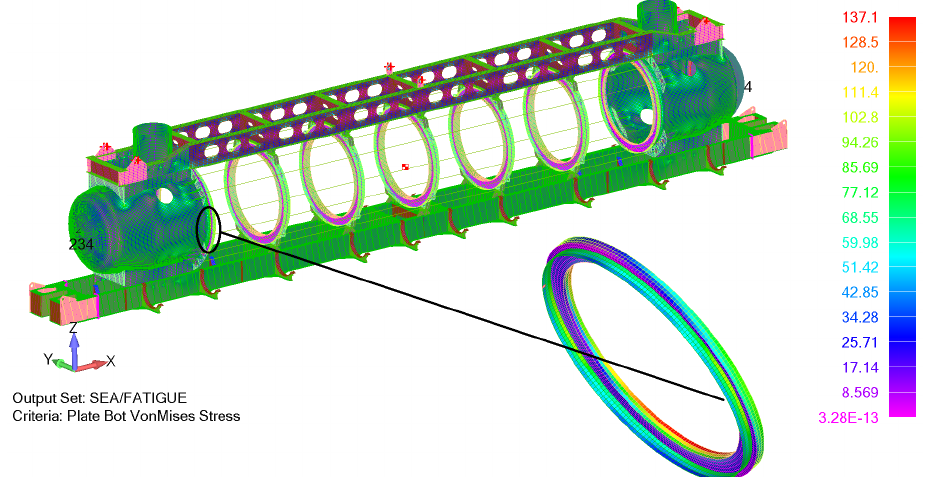
Figure 11. Plate bottom von Mises stresses for design depth and detail of the connection of the aft head and the first ring (stresses in MPa).